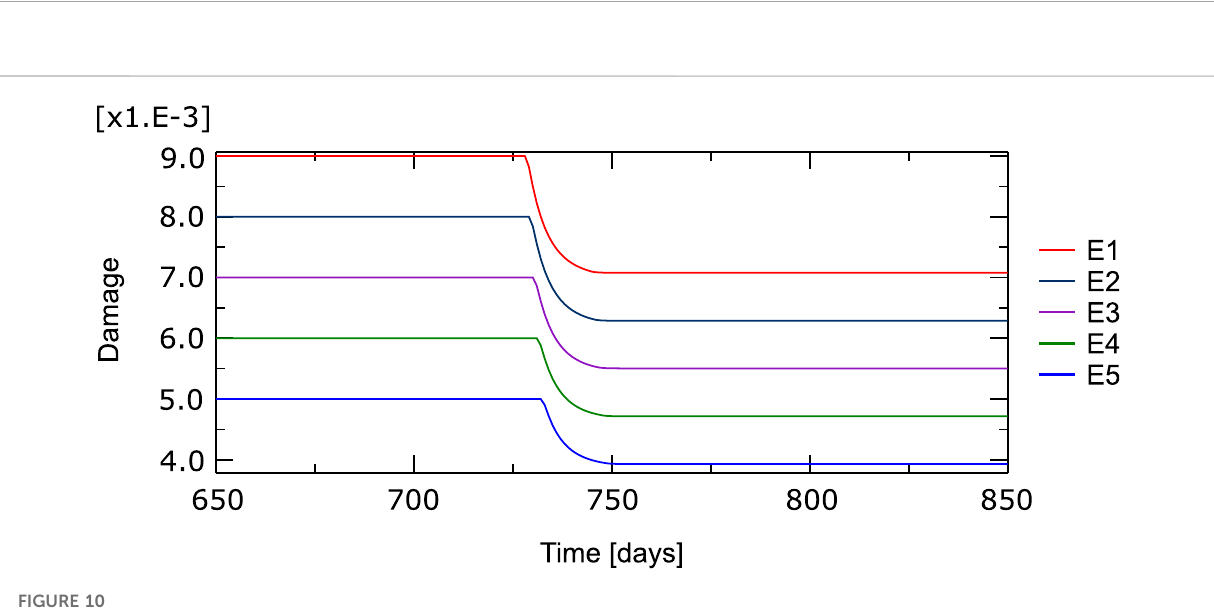
atday t andsubsequentdays.Theelementsarenamedinthe fi rstframefromE1toE5indecreasingorderofdamage(seeFigure4).Thecompressionload was applied in this case.